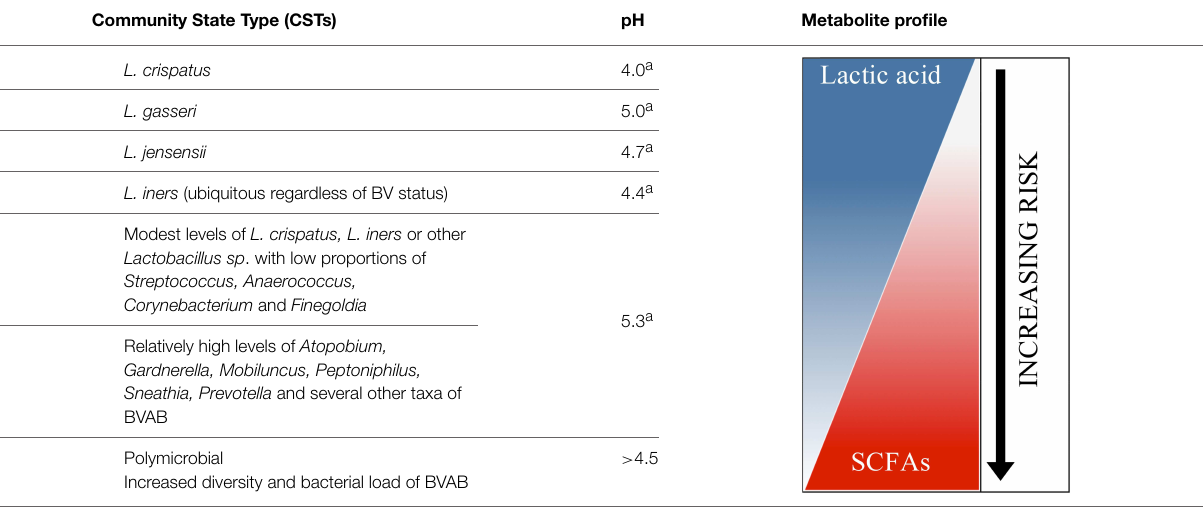
TABLE 1 | Microbial communities and metabolite spectrum in the vaginal ecosystem and their proposed relationship to risks of adverse sexual and reproductive outcomes. Community State Type